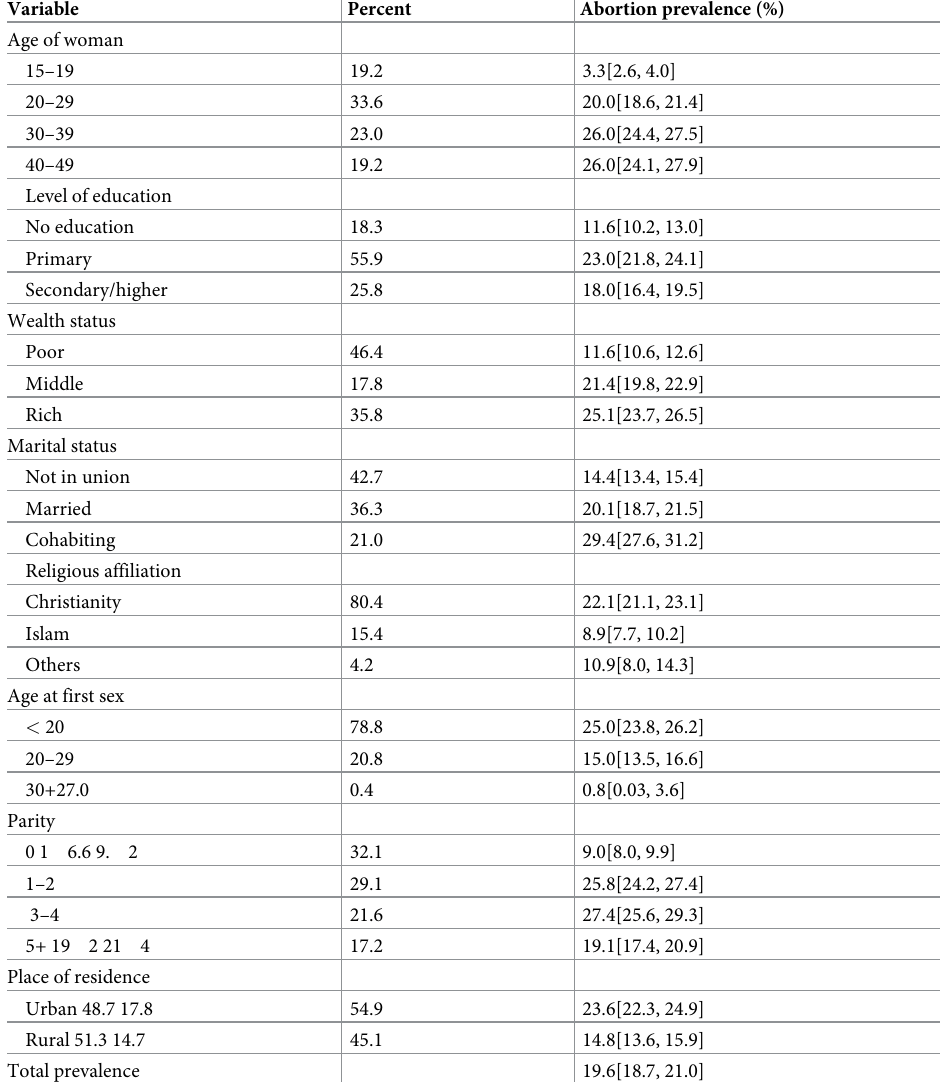
Table 1. Background characteristics of respondents and abortion